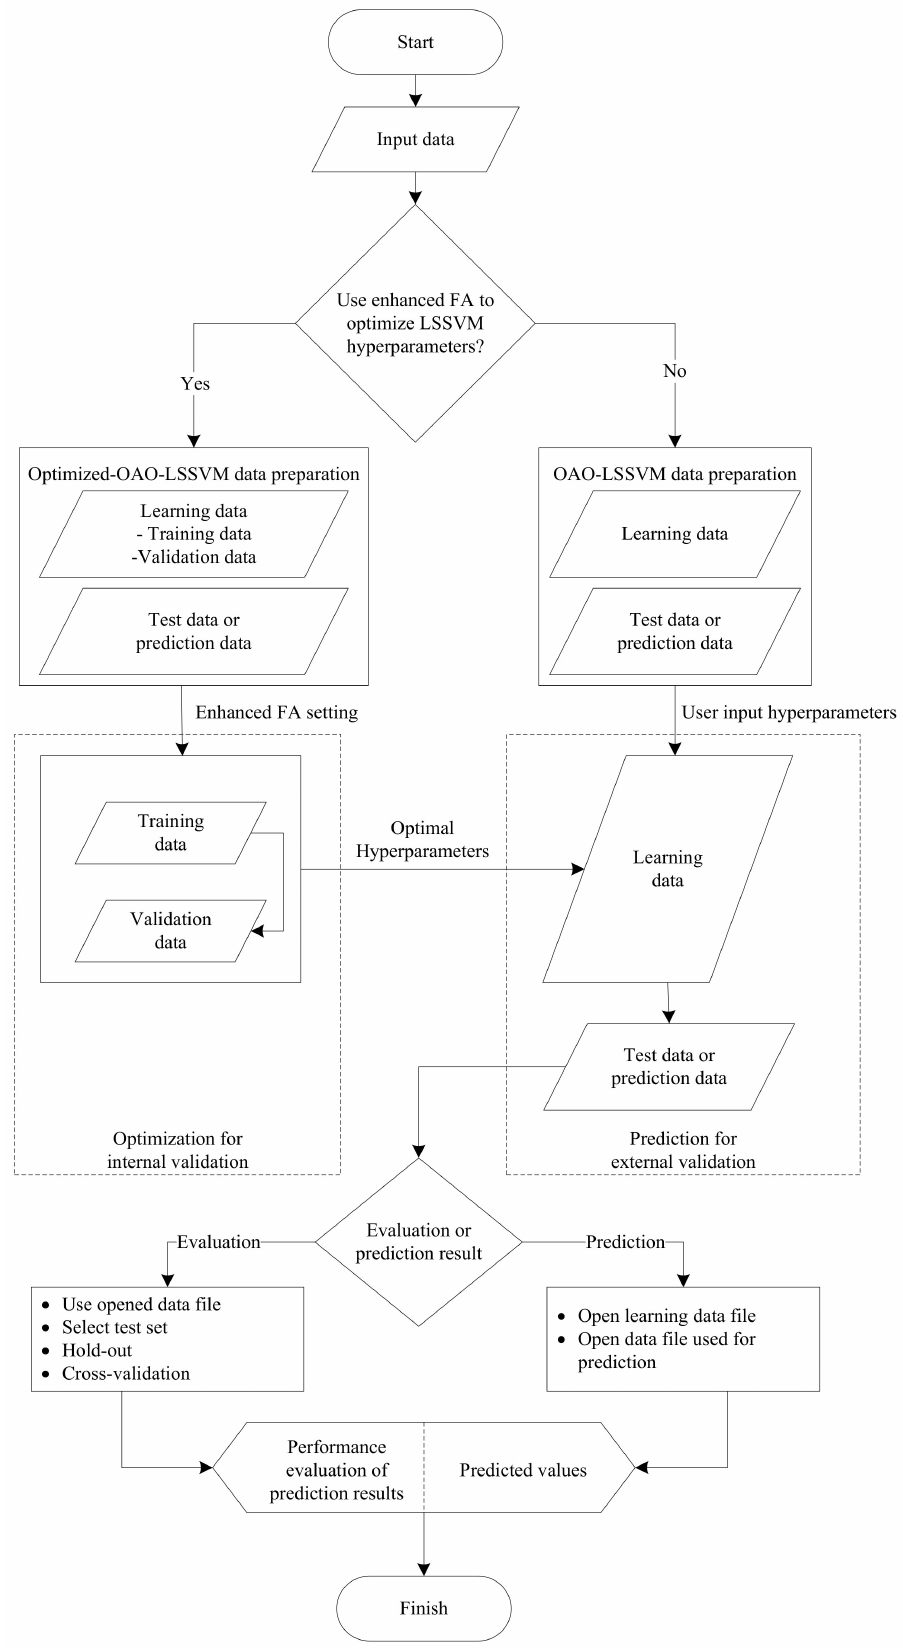
Figure 1. Metaheuristic-optimized multi-level classification system